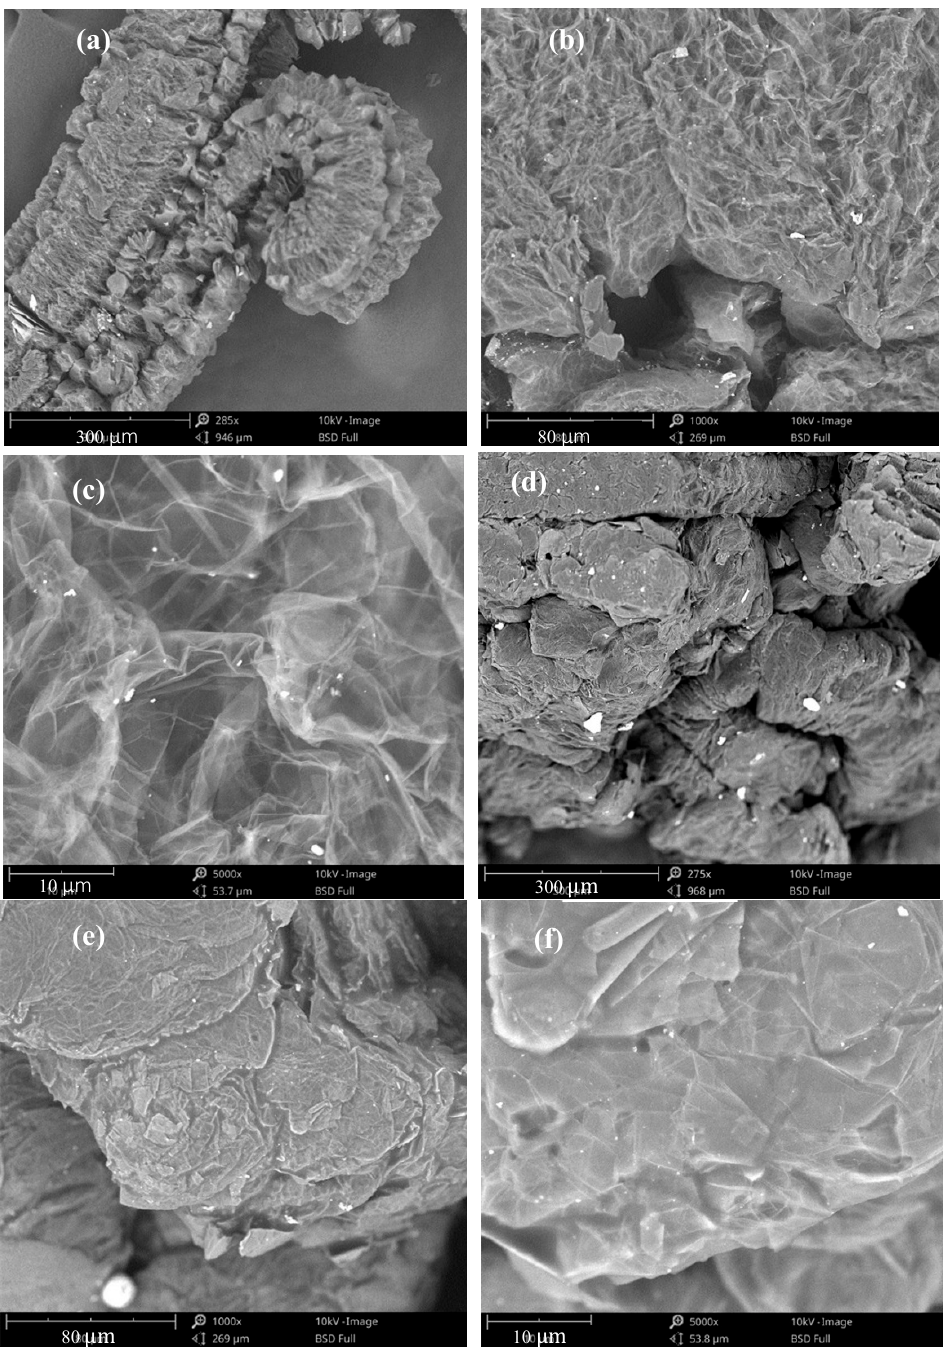
Figure 4. SEM images of EG and EG/P: ( a ) 285× magnification of EG; ( b ) 1000× magnification of EG; ( c ) 5000× magnification of EG; ( d ) 280× magnification of EG/P; ( e ) 1000× magnification of EG/P; ( f ) 5000× magnification of EG/P.